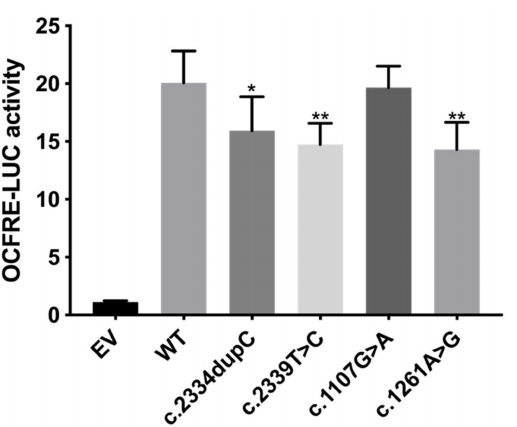
Figure 4. FGF reporter gene assay showing reduced signaling capacity of c.2334dupC, c.2339T>C and c.1261A>G. L6 myoblasts were transiently transfected with OCFRE-luciferase reporter together with wild type (WT) or mutant constructs and then treated with 10-8M FGF18. The average receptor signaling capacities of c.2334dupC, c.2339T>C and c.1261A>G were reduced by 20.7%, 26.6% and 28.8%, respectively. EV = empty vector. * p value < 0.05, ** p value <